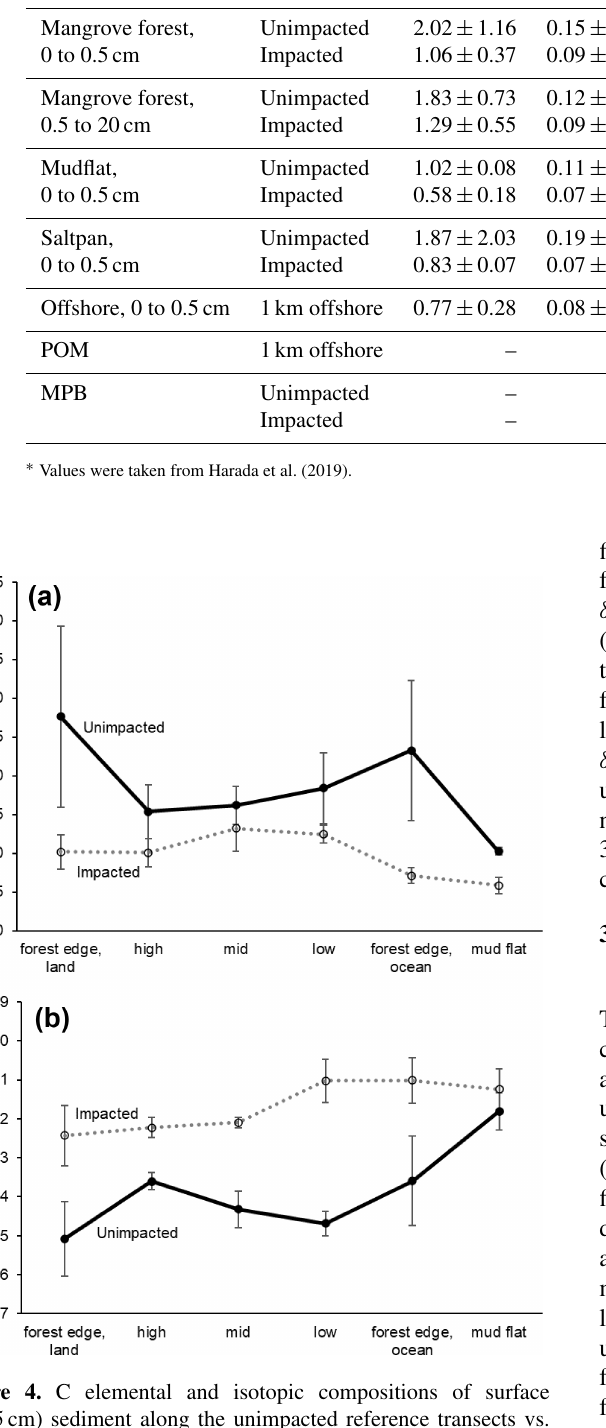
Table 3. Elemental and isotopic compositions of sediment in 2018, 32 months after the dieback (mean, SD). Forest/site